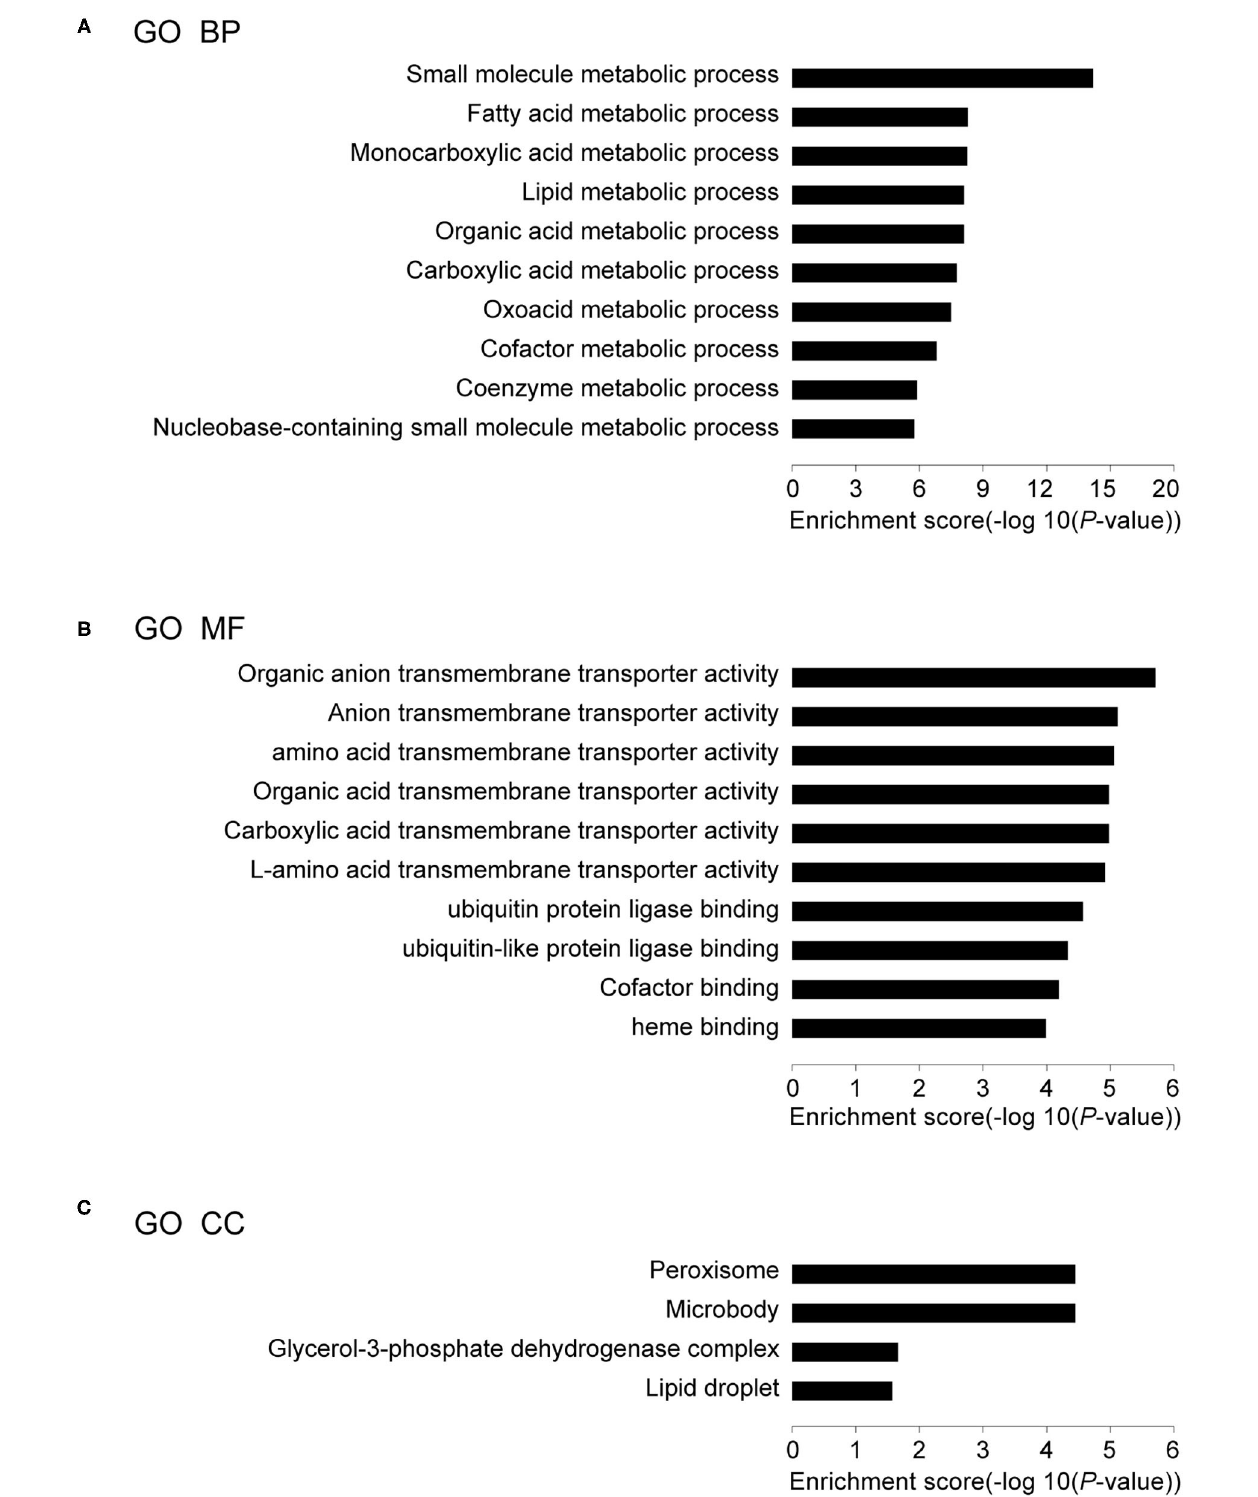
FIGURE 3 | Results of GO analysis. (A) Top 10 GO biological processes, (B) Top 10 GO MF, and (C) Top 4 GO CC in IUGR compared with AGA.